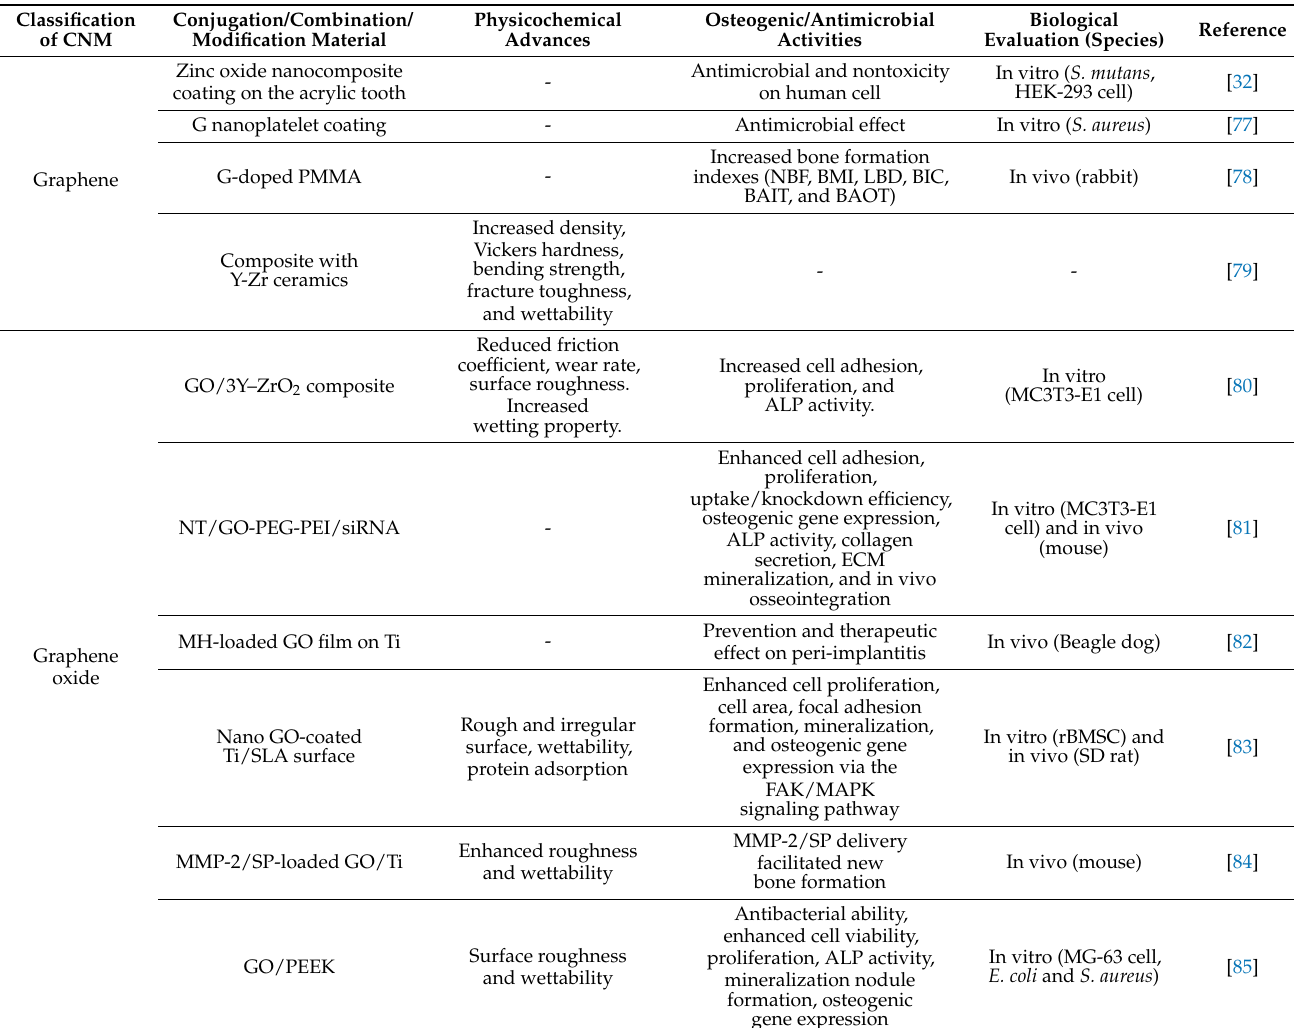
Table 1. Recent studies on CNMs for dental implant